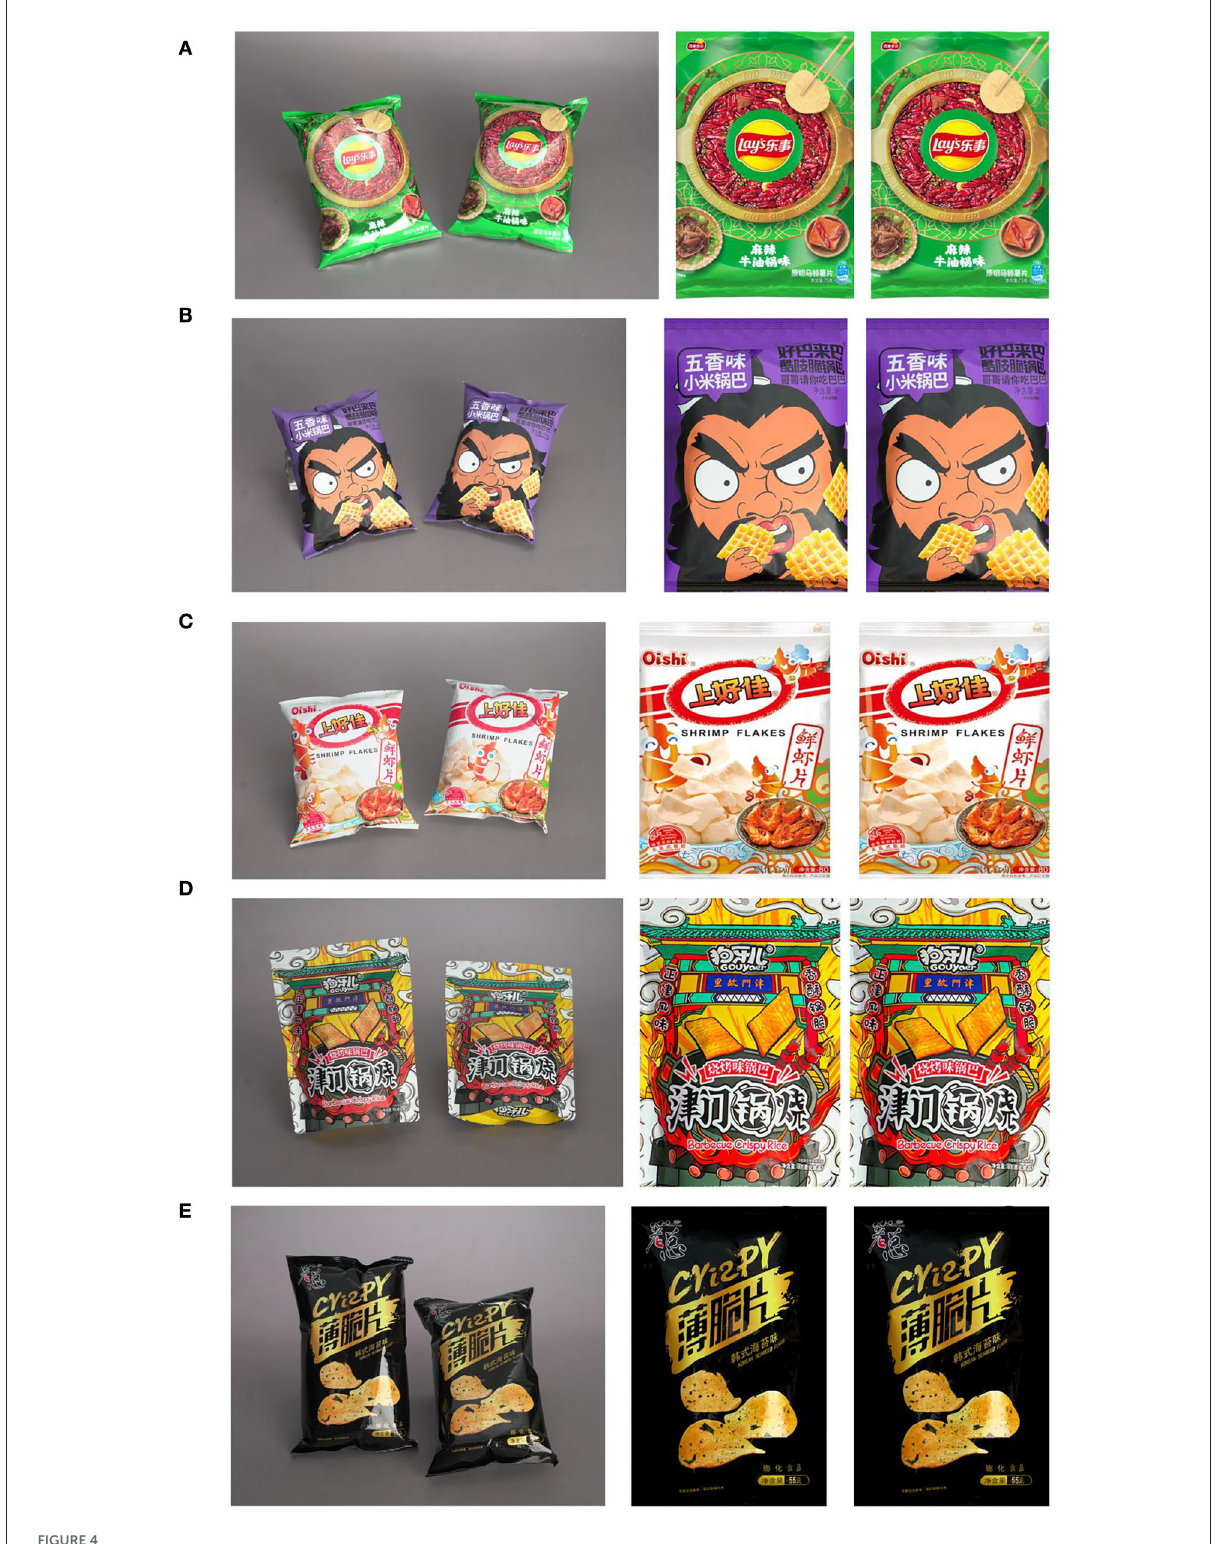
FIGURE4 Examples of experimental data set: (A) one example in class 1 (with score 1); (B) one example in class 2 (with score 2); (C) one example in class 3 (with score 3); (D) one example in class 4 (with score 4); (E) one example in class 5 (with score